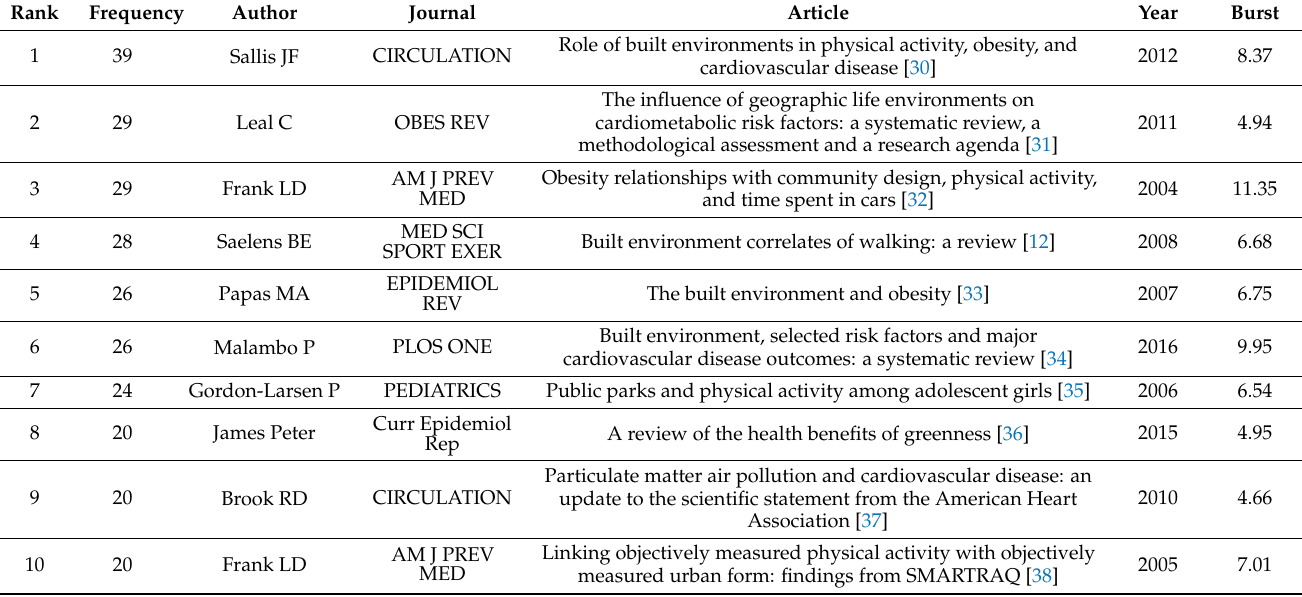
Table 6. The top 10 cited